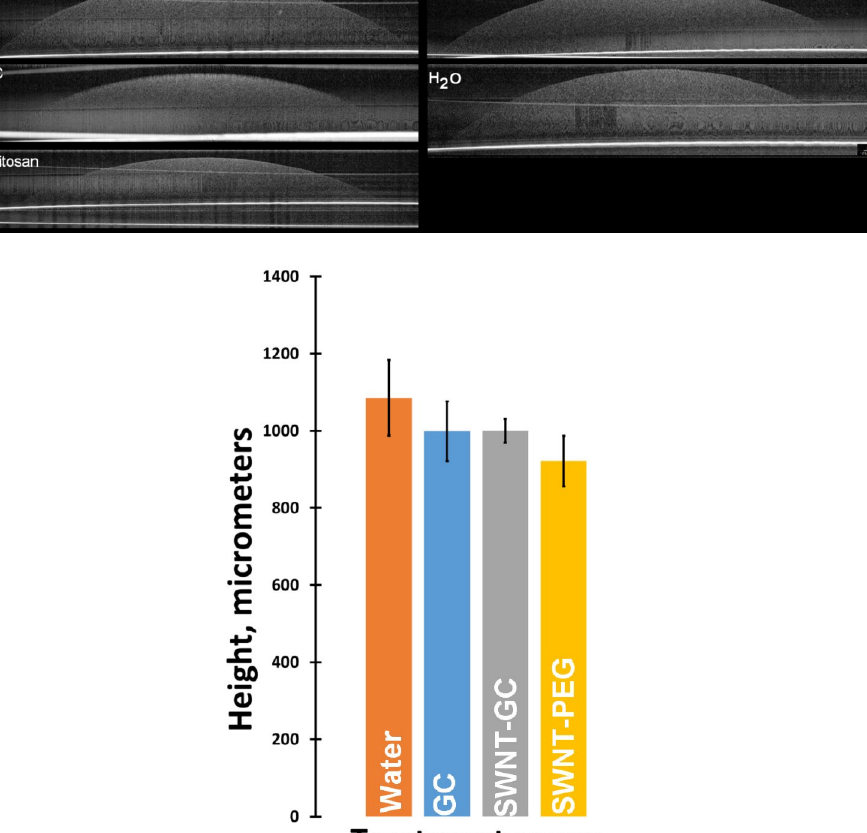
Figure 3. Cell-free matrices with chitosan derivatives demonstrated similar size to water control matrices when viewed with OCT. ( Top ) Matrices were plated using a reduced volume so that the entire height was visible within the depth constraints of the OCT imager. Tissues were imaged 48 h after plating. All matrices were of similar size. ( Bottom ) Bar graph showing the average height of samples after 48 h of culture. Only SWNT-PEG means were SD from control means.